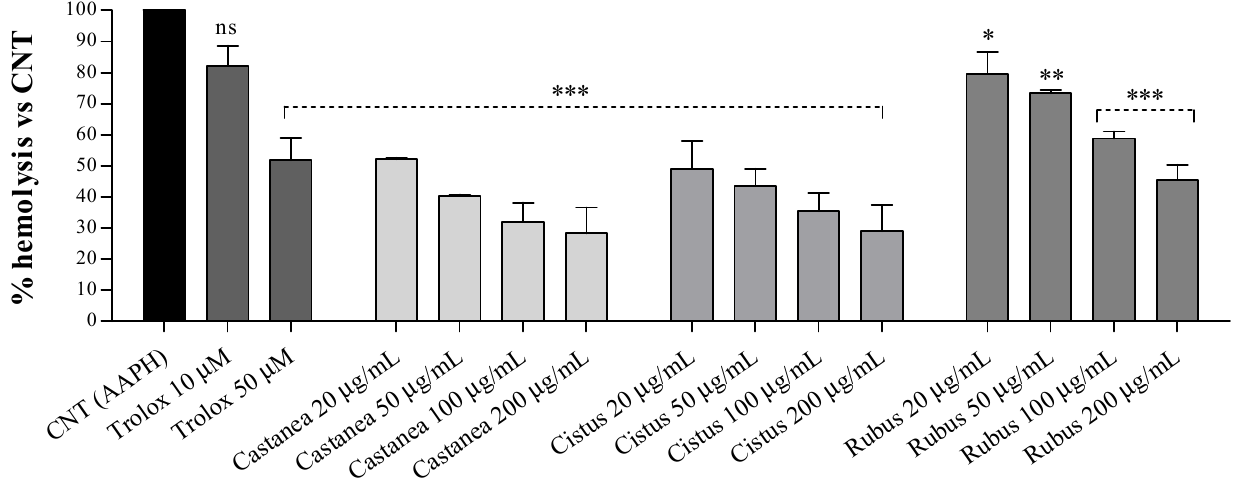
Figure 2. Effects of increasing concentrations (20, 50, 100, and 200 µg/mL) of Castanea , Cistus and Rubus bee pollen extracts on erythrocytes AAPH-induced oxidative hemolysis. Trolox (10 and 50 µM) was used as a standard. Results were expressed as mean ± SD. One-way ANOVA with Tukey’s multiple comparison test: * significantly different from CNT (AAPH-treated cells), * p < 0.05, ** p < 0.01, *** p < 0.001. ns: not statistically significant.